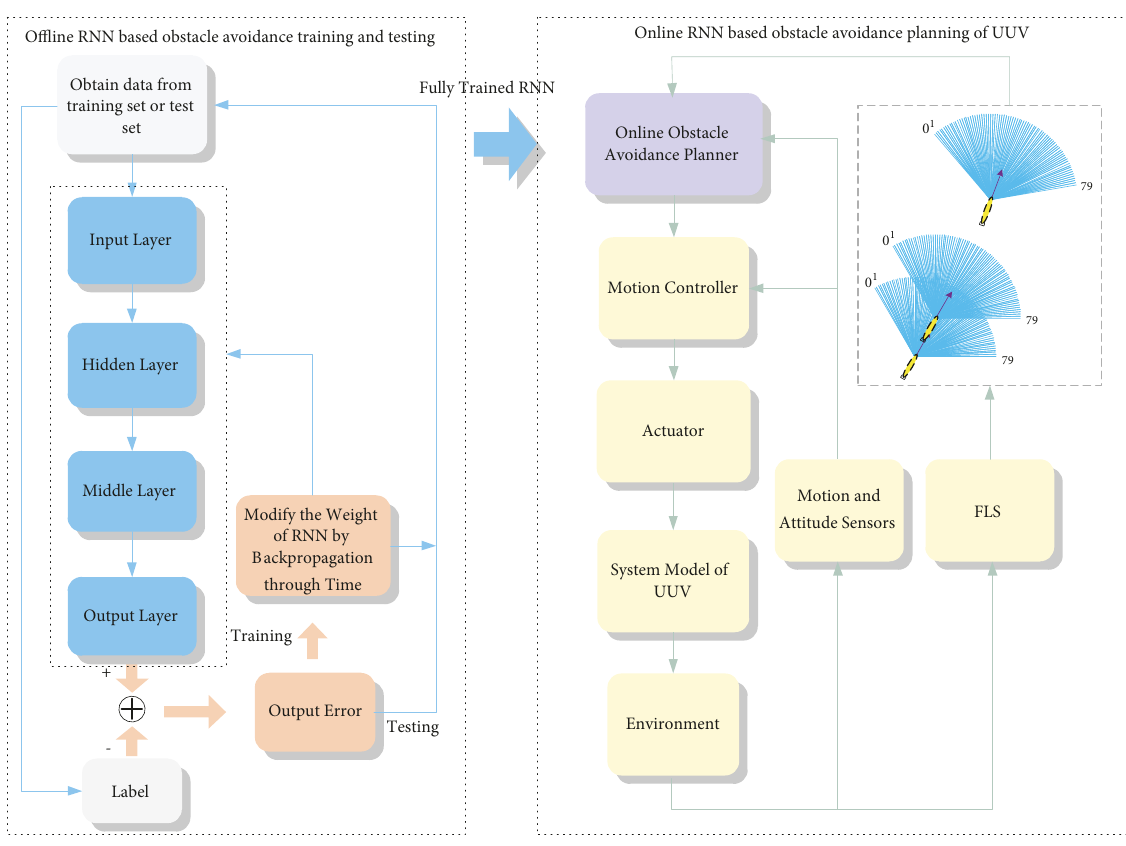
Figure 4: Principle framework of RNN based obstacle avoidance planning learning